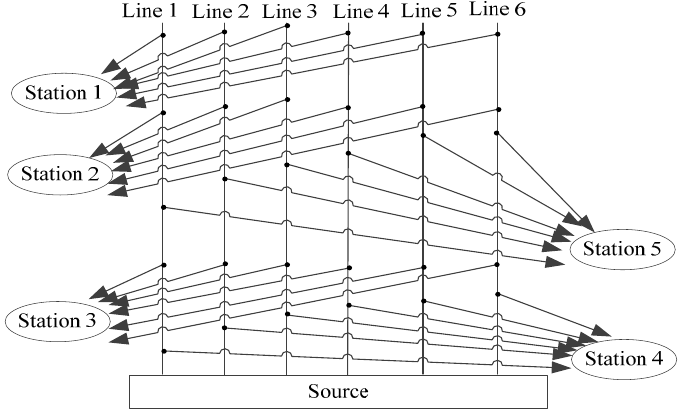
Figure 7. Multiple line transmission system [1].